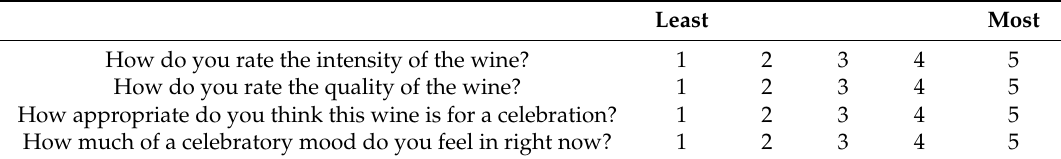
Table 3. The four ratings that participants were asked to give for each